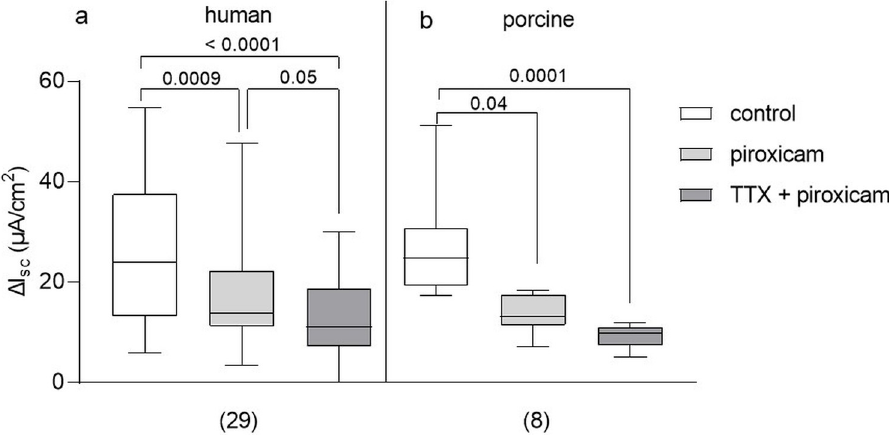
Fig 7. Involvement of prostaglandins in mediating the distension induced secretory response. Addition of piroxicam prior to P ser reduced secretory response in human (a) and porcine tissue (b). Simultaneous incubation with TTX further reduced the response in human tissue (human: Friedman test with Dunn’s multiple comparison test; porcine: Kruskal-Wallis test with Dunn’s multiple comparison test; p values above brackets). Data shown are the medians with the 25 th and 75 th quartiles as a box plot and the minima and maxima as a whisker plot. N numbers are given in parenthesis.